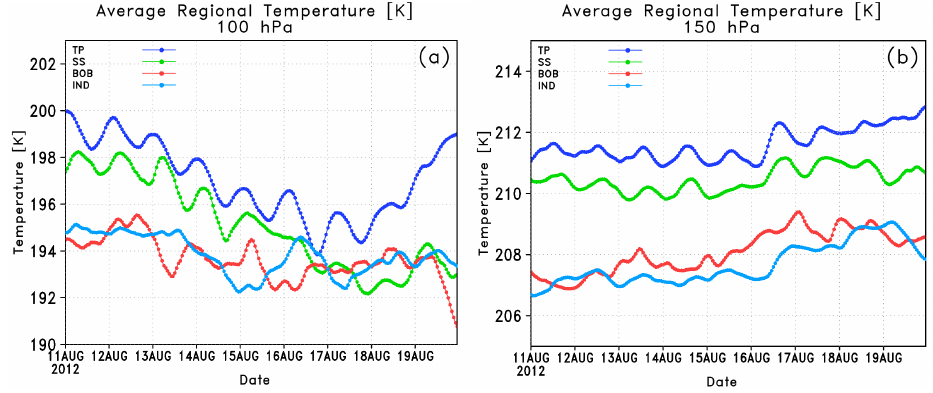
Fig. 12. WRF-simulated area average temperature (K) at 100hPa (a) and 150hPa (b) for the TP, SS, BOB, and IND